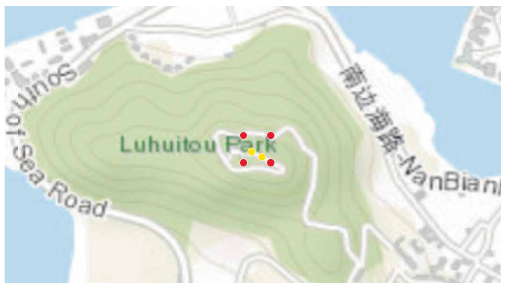
Figure 7: Actual position of the